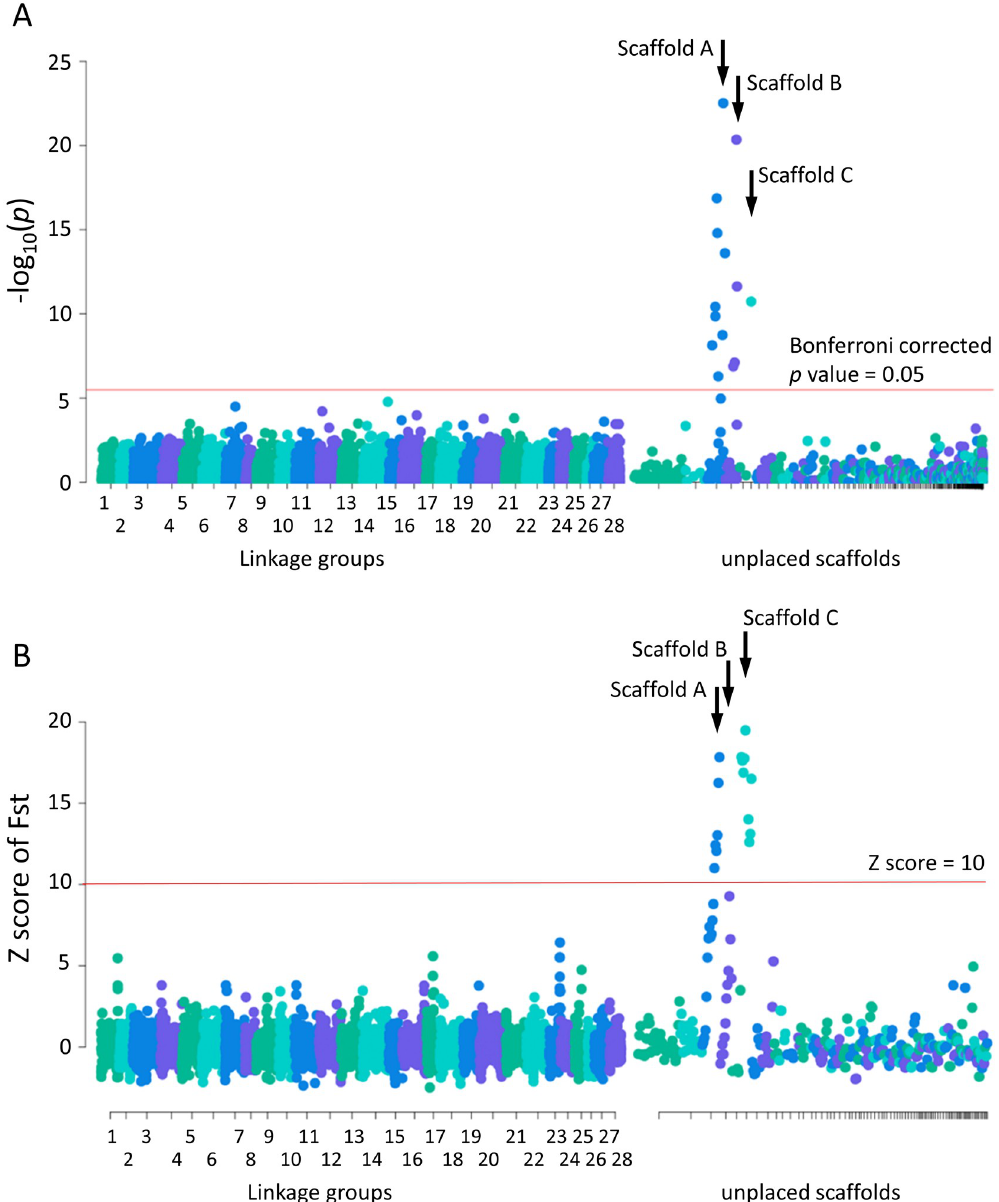
Fig 2. Genome-wide association analysis of sex-associated locus. (A) Manhattan plots for genome-wide association mapping of sex in ayu population. Male-associated SNPs were detected in three scaffolds. X-axis: linkage groups and scaffolds. Y-axis: − log 10 ( p -value) based on association test. Red line indicates genome-wide significance threshold (Bonferroni corrected p -value = 0.05). (B) Genomic scan for evidence of genetic divergence between males and females using SNPs detected by whole-genome resequencing. Each dot represents Z scores of Fst values calculated for a 100-kb windows in 50-kb steps along the genome. Scaffolds in which male-associated SNPs were located by genome-wide association study also had the highest Fst